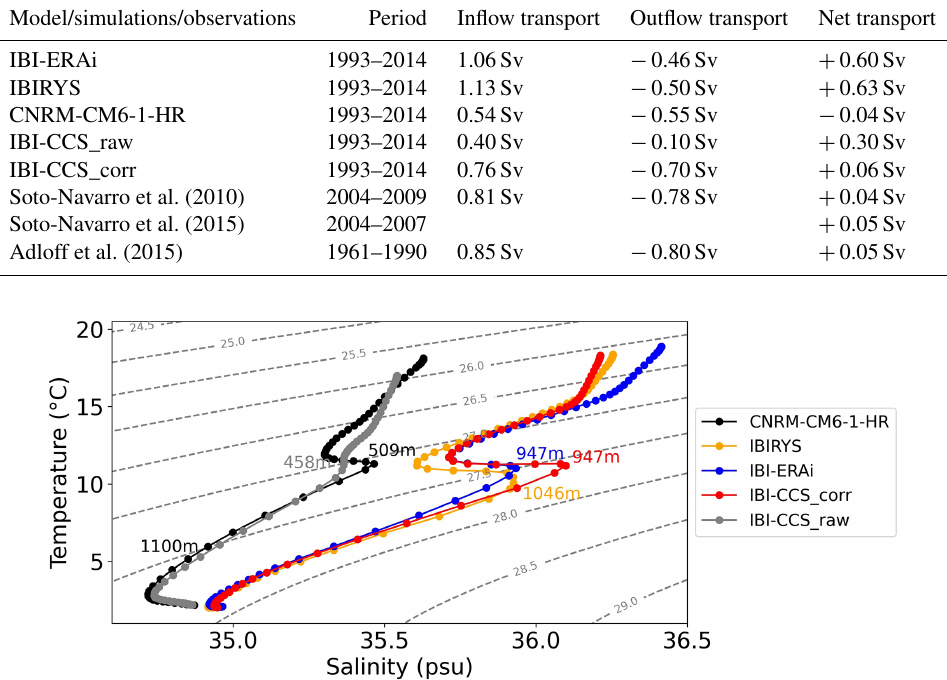
Table 3. Transport through the Strait of Gibraltar in the different simulations in comparison to previous studies. Transport is positive eastward. Model/simulations/observations